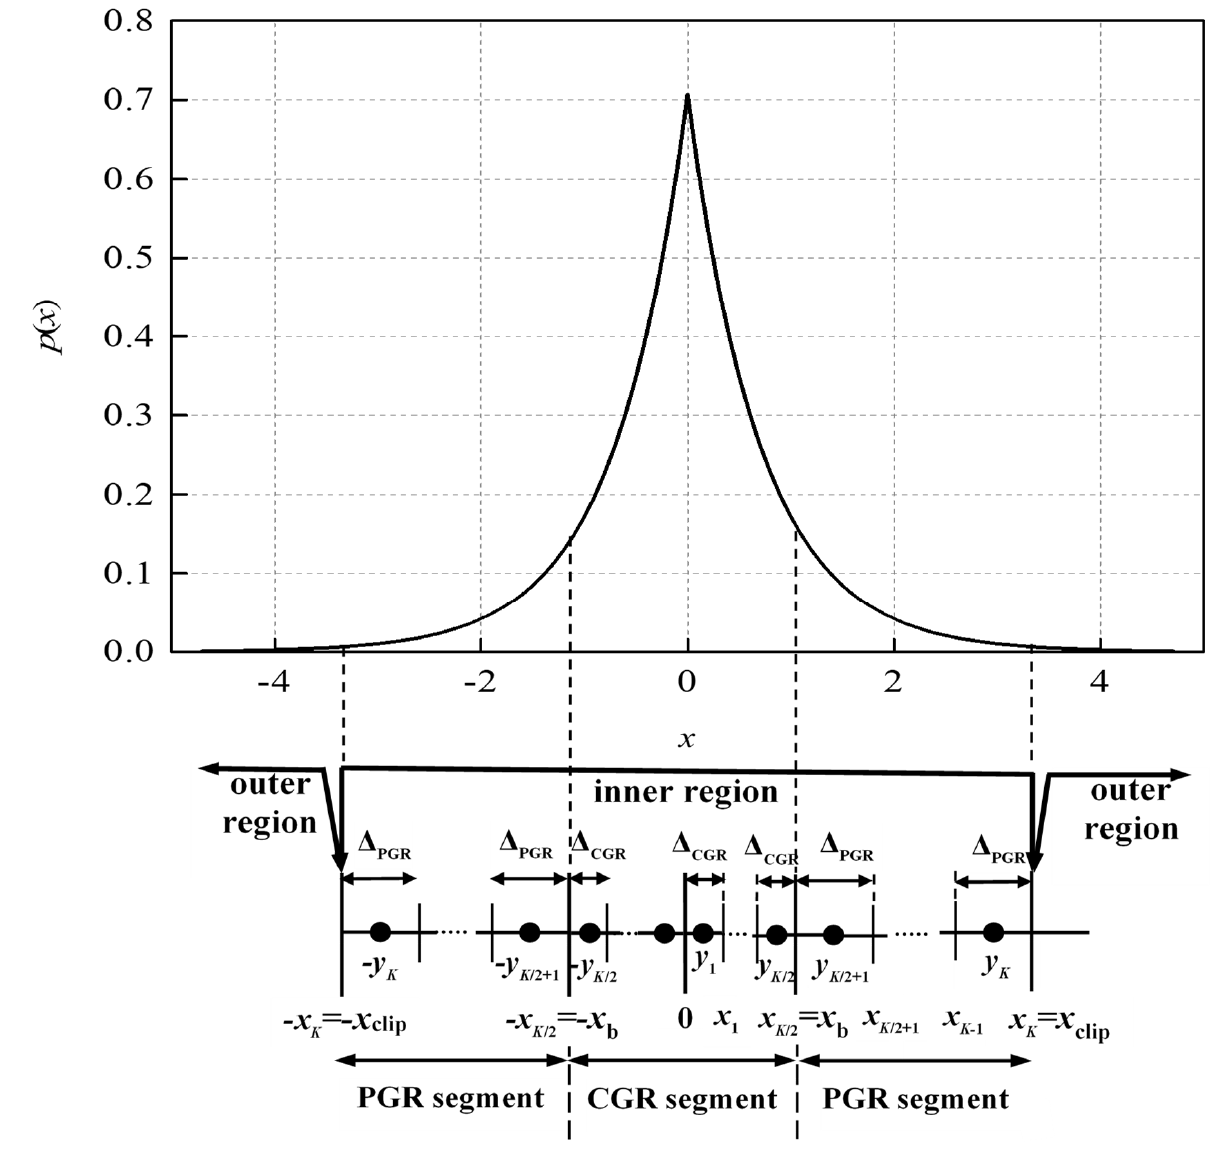
Figure 1. Support region partition into CGR and PGR: Δ CGR and Δ PGR are cell widths in the ℜ CGR and ℜ PGR , x i , i = 1, …, K are nonnegative decision thresholds, y i , i = 1, …, K are nonnegative representation levels.